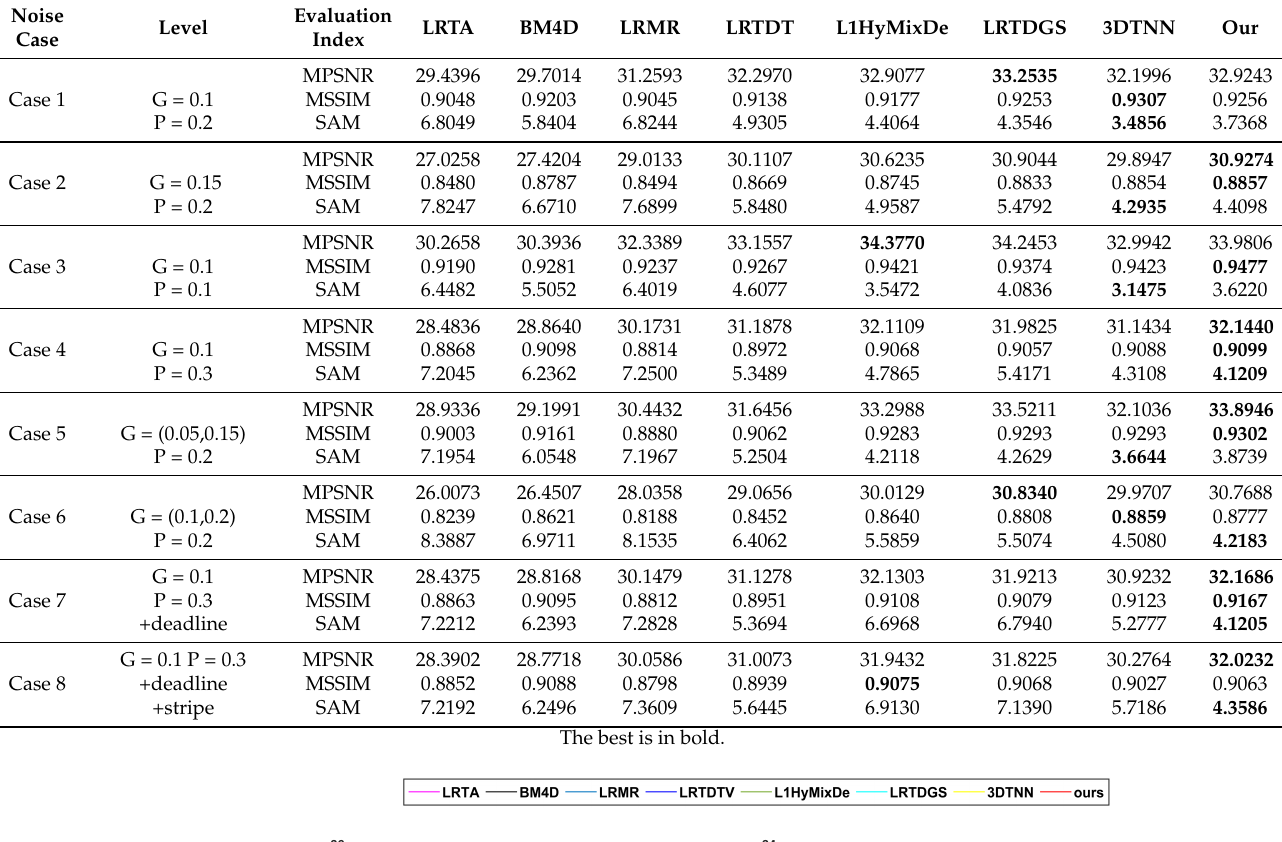
Table 3. The value of quantitative indices in the dataset-1.